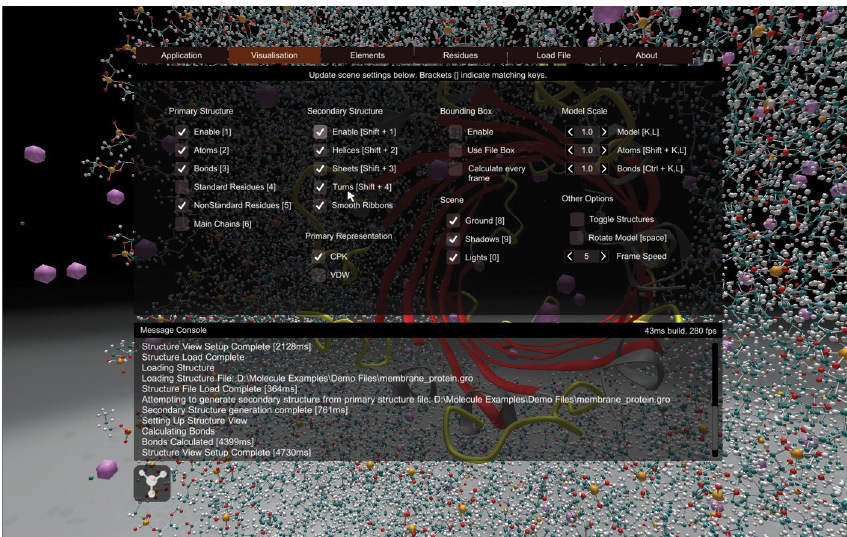
Figure 1: User interface in 2D on desktop PC.